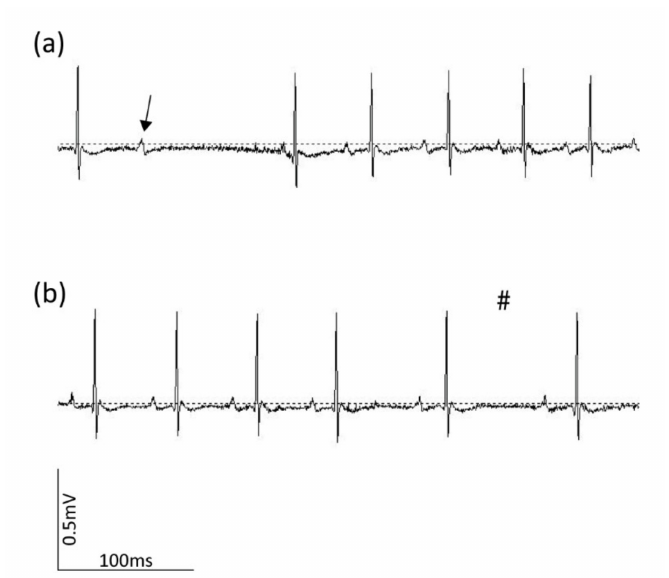
Figure 7. P-wave analysis on representative mouse ECG files at a sample rate of 2000 Hz. ( a ) Blocked P-wave based on the presence of a P-wave (indicated with arrow) without subsequent QRS-complex. ( b ) Sinus arrest based on the absence of an extra P-wave in between a long RR-interval. Vertical and horizontal scale bars represent 0.5 mV and 100 ms, respectively. Hashtag indicates absence of p-wave indicating sinus arrest.